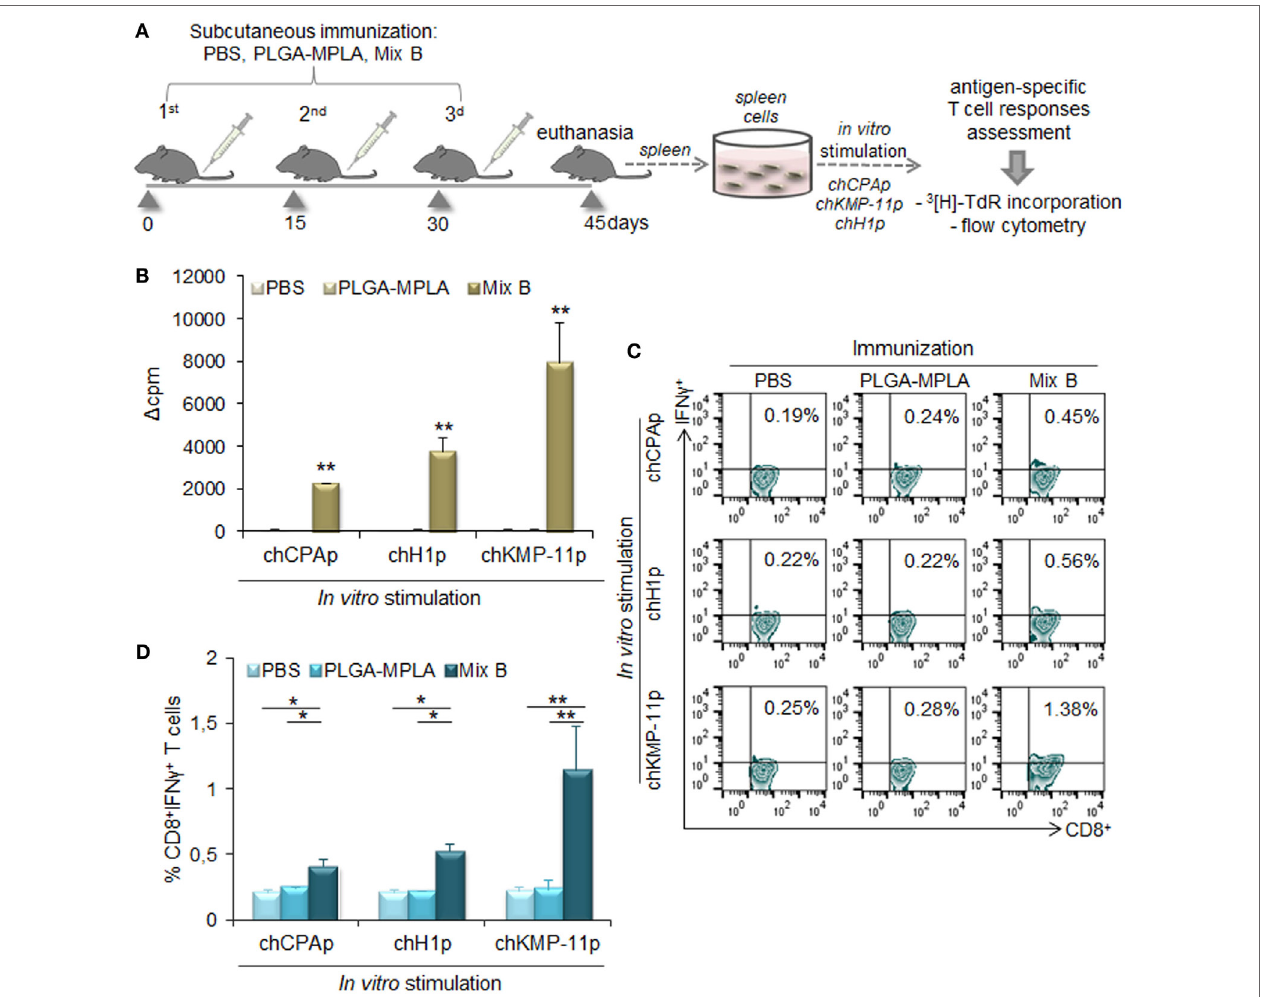
FigUre 10 | Immunization with the mix of peptide-based poly(lactic- co -glycolic) acid (PLGA) nanoformulations with monophosphoryl lipid A (MPLA) incorporation induced peptide-specific T cell responses in HLA A2.1 transgenic mice. (a) Immunization scheme. Mice were subcutaneously immunized with the mix of PLGA- chCPAp-MPLA, PLGA-chH1p-MPLA, and PLGA-KMP-11p-MPLA nanoformulations (mix B), PLGA-MPLA nanoformulations or only PBS. Two weeks after the last boosting dose, the spleen of each mouse was aseptically removed and spleen cells were stimulated in vitro with each of the chimeric peptides (chCPAp, chH1p, and chKMP-11p) in order to assess induced peptide-specific T cell responses. (B) Peptide-specific T cell expansion was measured by 3 [H]-TdR incorporation. Samples were run in triplicates. Results are represented as Δ cpm ± SD (cpm of stimulated spleen cells—cpm of unstimulated spleen cells), and significant differences are indicated by ** p < 0.01. (c,D) In vitro -stimulated spleen cells were stained with fluorochrome-labeled anti-CD3, anti-CD8, and anti-IFN γ monoclonal antibodies and analyzed with flow cytometry. (c) The representative contour plots depict the peptide-specific IFN γ -producing CD8 + T cells. (D) The diagrams show the percentage of peptide-specific IFN γ -producing CD8 + T cells. Results are expressed as the mean ± SD and significant differences between spleen cells from mice immunized with mix B and spleen cells from mice immunized with PLGA-MPLA or PBS are indicated by * p < 0.05 or ** p <